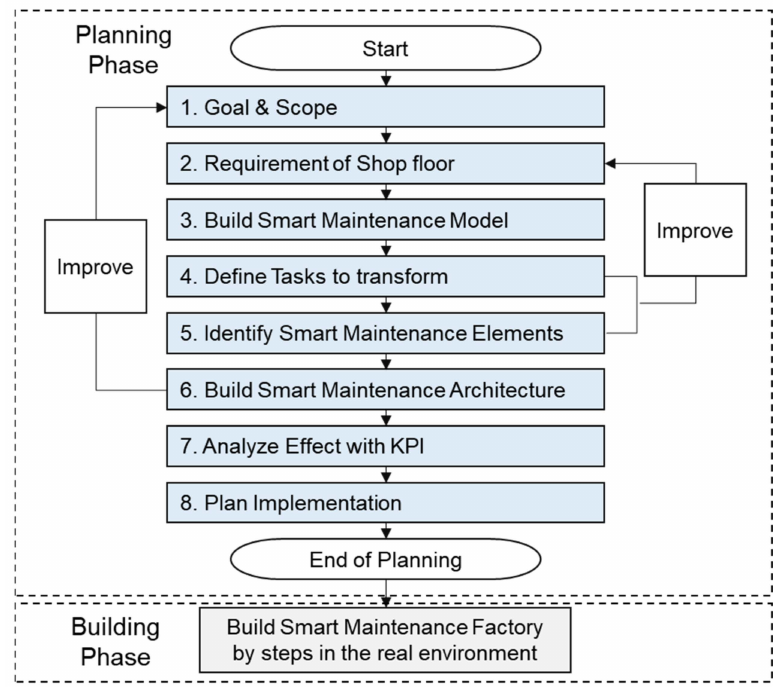
Figure 3. Implementation